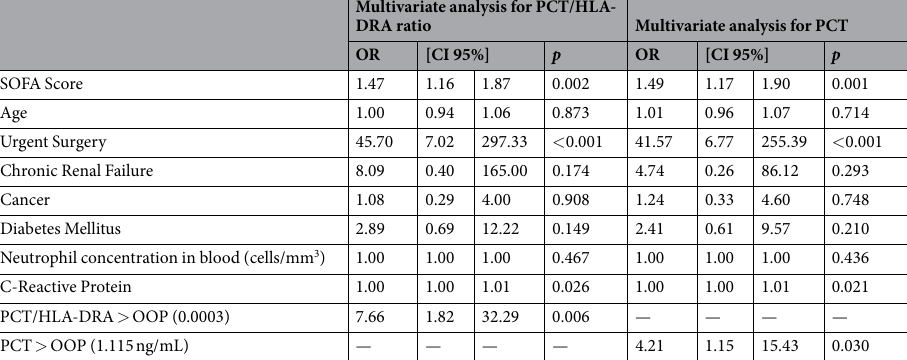
Table 3. Multivariate analysis for evaluating the risk of sepsis in the derivation cohort based on the PCT/HLA- DRA ratio or Procalcitonin levels. OOP: Optimal operating point.